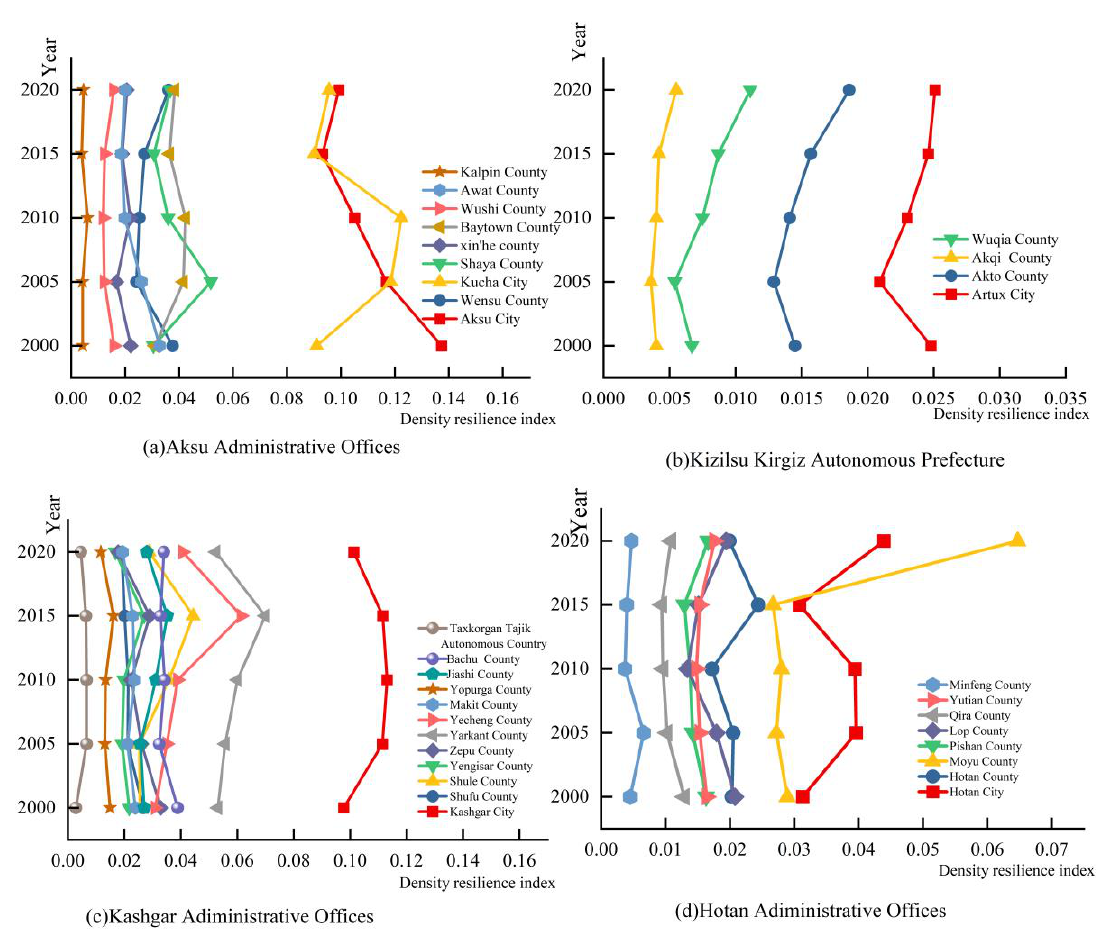
Figure 6. ( a ) Density resilience index of Aksu Administrative Offices from 2000 to 2020. ( b ) Density resilience index of Kizilsu Kirgiz Autonomous Prefecture from 2000 to 2020. ( c ) Density resilience index of Kashgar Administrative Offices from 2000 to 2020. ( d ) Density resilience index of Hotan Administrative Offices from 2000 to 2020.